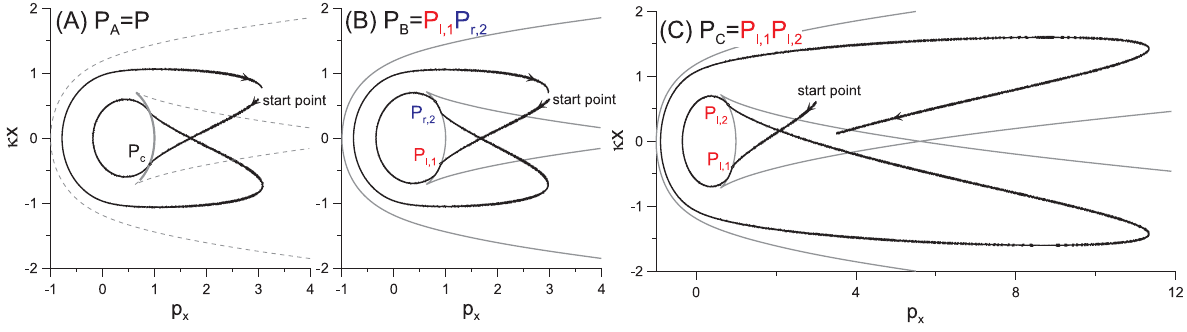
Fig. 12. Three panels show projections of trajectories from Fig.11 to the plane (κx,p x ) . Probabilities of all trajectories corresponds to combination of probabilities at the uncertainty